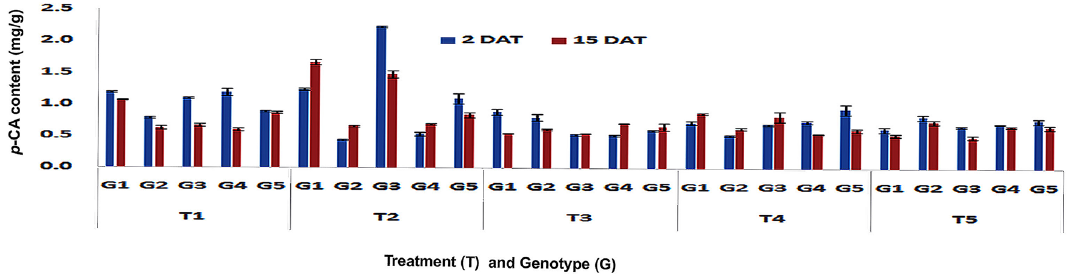
Figure 1. Changes in p -CA content in leaf tissues of maize genotypes to induced treatments in short (2 DAT) and long (15 DAT) term responses on the imposition of treatments at V3 stage (G1: DMRE 63; G2: CM 500; G3: WNZ Exoticpool; G4: CM 202; G5: BML 6; T 1 : Control; T 2 : PSB feeding; T 3 : Wounding; T 4 : Combination of wounding plus regurgitation; T 5 : Exposure to methyl jasmonate).